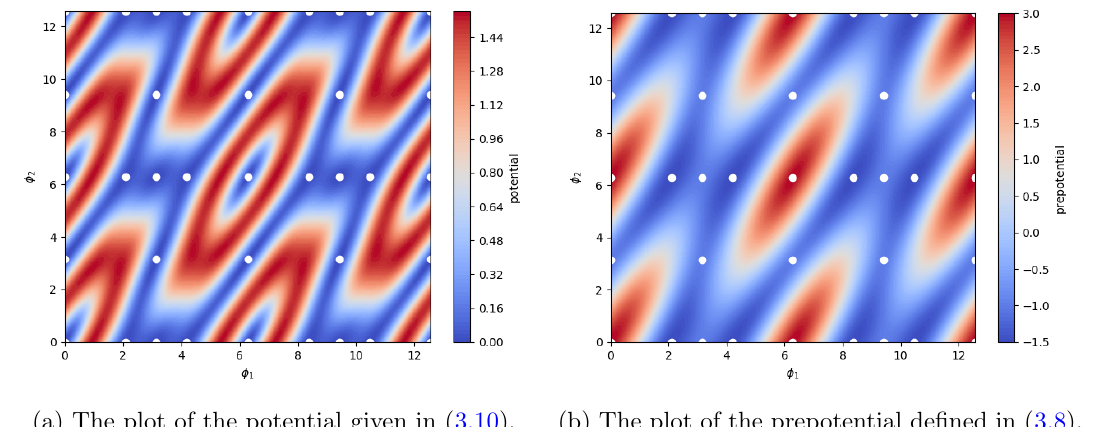
Figure 1. The plots of the potential and of the prepotential for the g 2 algebra FKZ model. The corresponding discrete vacua are de(cid:12)ned at the points on the plane (cid:30) 1 (cid:0) (cid:30) 2 with white dots. The vacua are seen to be localised at the points of extremum of the prepotential which always correspond to points of minima of the